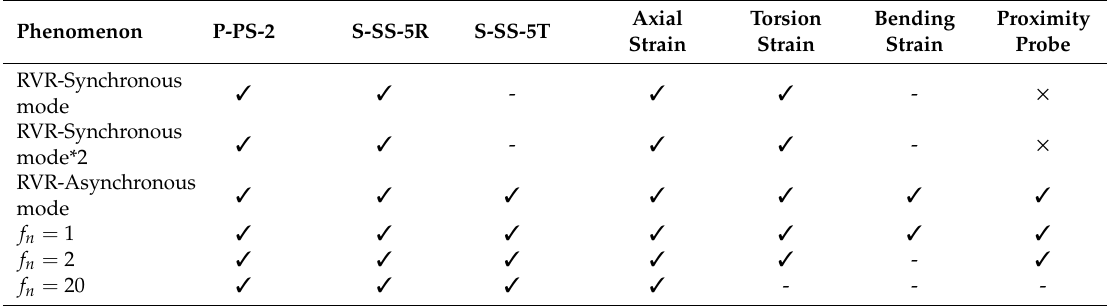
Table 3. A summary of the spectral analysis results regarding hydraulic phenomena detection with transducers installed in the rotating and stationary frame of reference; (cid:51) , -, and × denote ‘detected’, ‘not detected’, and ‘the transducer is not applicable’,